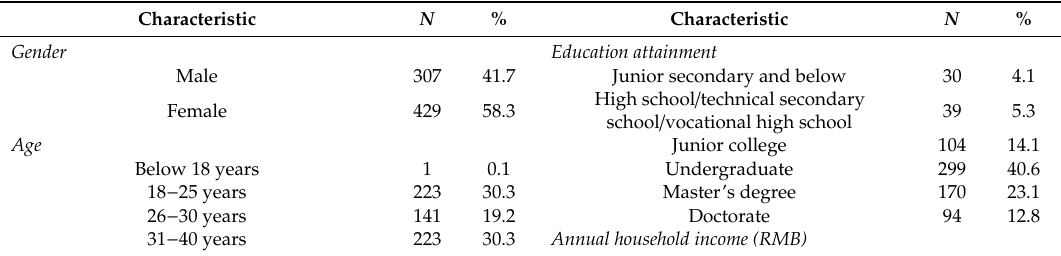
Table 1. Socio-demographic characteristics of the